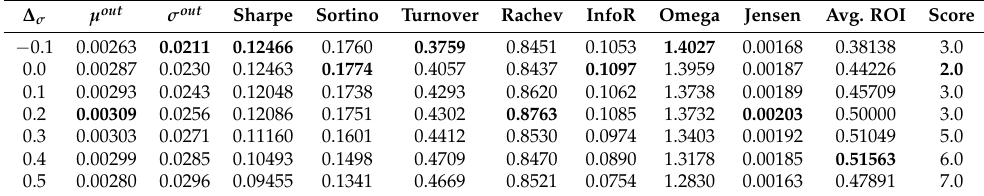
Table 12. ETF: out-of-sample performance results for the RMZ R strategy by varying ∆ σ (with ∆ γ = 0.3).